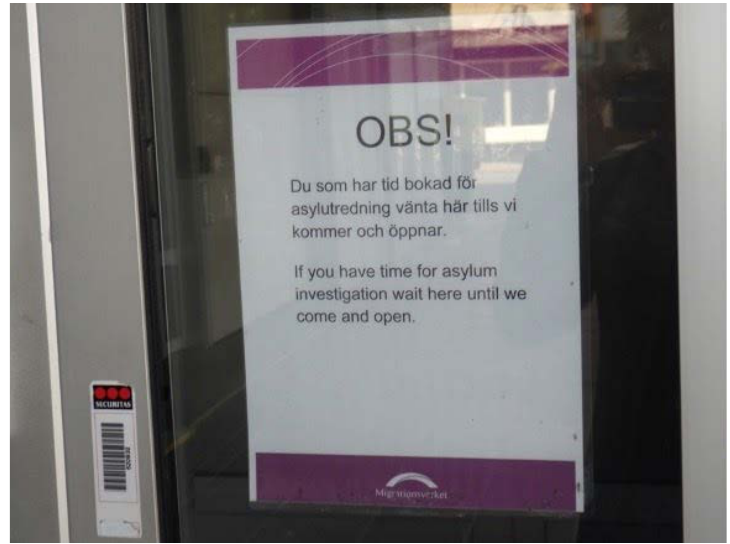
Figure 6. Government Information Paper.